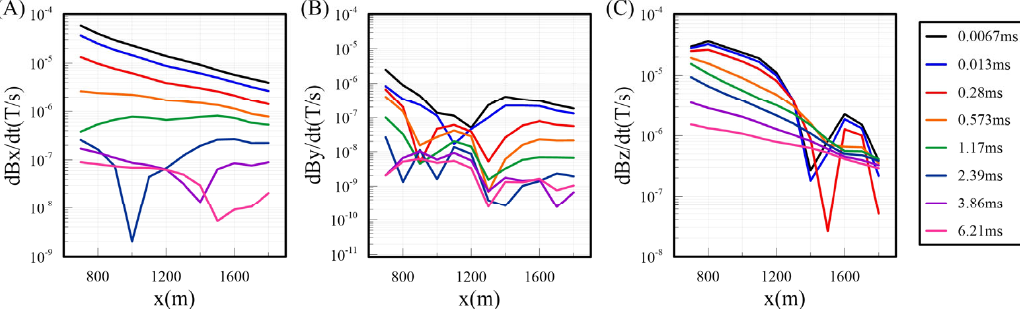
Figure 6. Multi ‐ component responses of inclined ore body model at y= 700 m. ( A – C ) are the X Figure 6. Multi-component responses of inclined ore body model at y = 700 m. ( A – C ) are the X component, Y component and Z component, respectively. component, Y component and Z component,